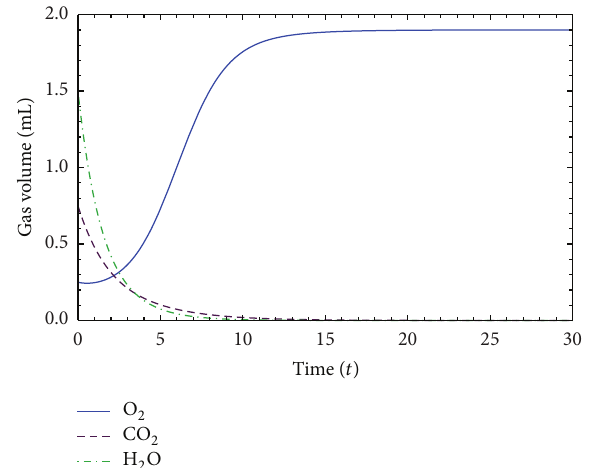
Figure 3: This figure illustrates the case when equilibria 𝐸 1 and 𝐸 3 are both unstable. The condition for instability is (𝑓 − 𝑠)/𝑒 > (𝑁 𝑑 + 𝑊 )/ℎ𝑁 𝐾 = 5 , 𝑢 = 0.7 , 𝑓 = 0.5 , 𝑁 𝑗 1 𝑓 . For this case we choose 𝑠 = 0.03974 , 𝑒 = 0.8 , and ℎ = 2.7